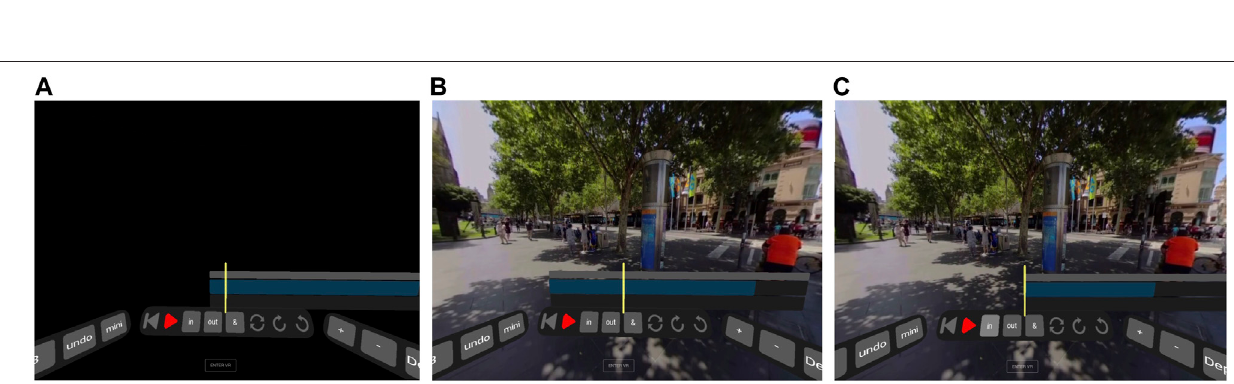
FIGURE3| Arrangingvideoclips. (A) TheuserhoversoverandselectsthesecondclipinthetimelineusingtheVRcontroller(highlighted inturquoise). (B) Theuser hovers over and selects the last clip (highlighted in turquoise). (C) The user presses the swap button. f) The two clips are now swapped. Video material: http://